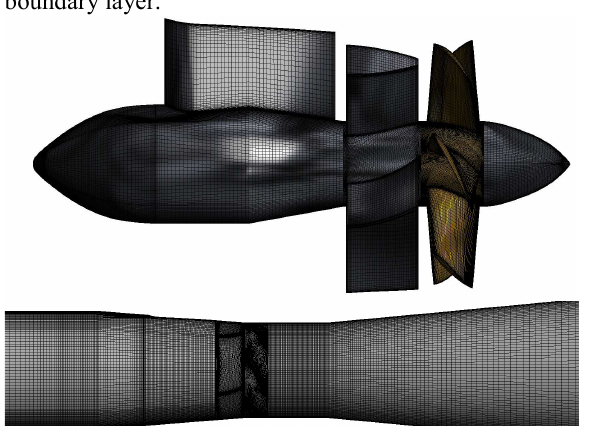
Fig. 5 Flow analysis - computational